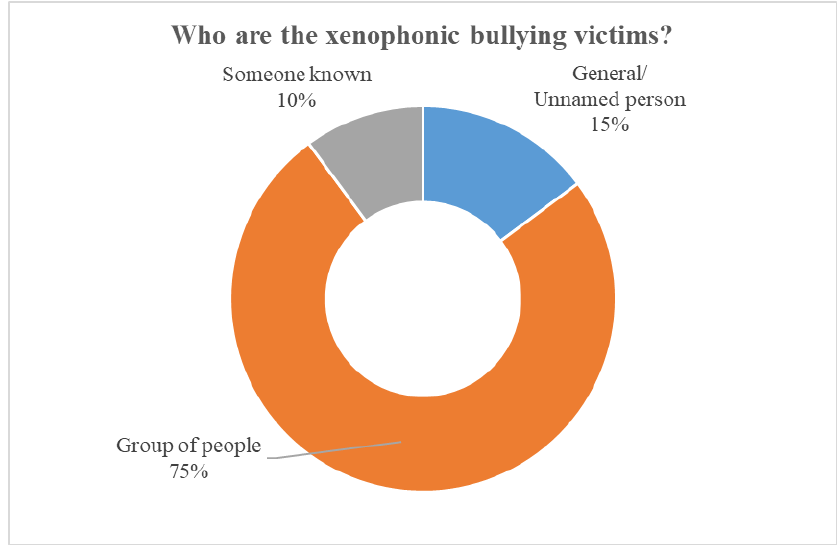
Figure 1. Xenophobic bullying victim characteristics.